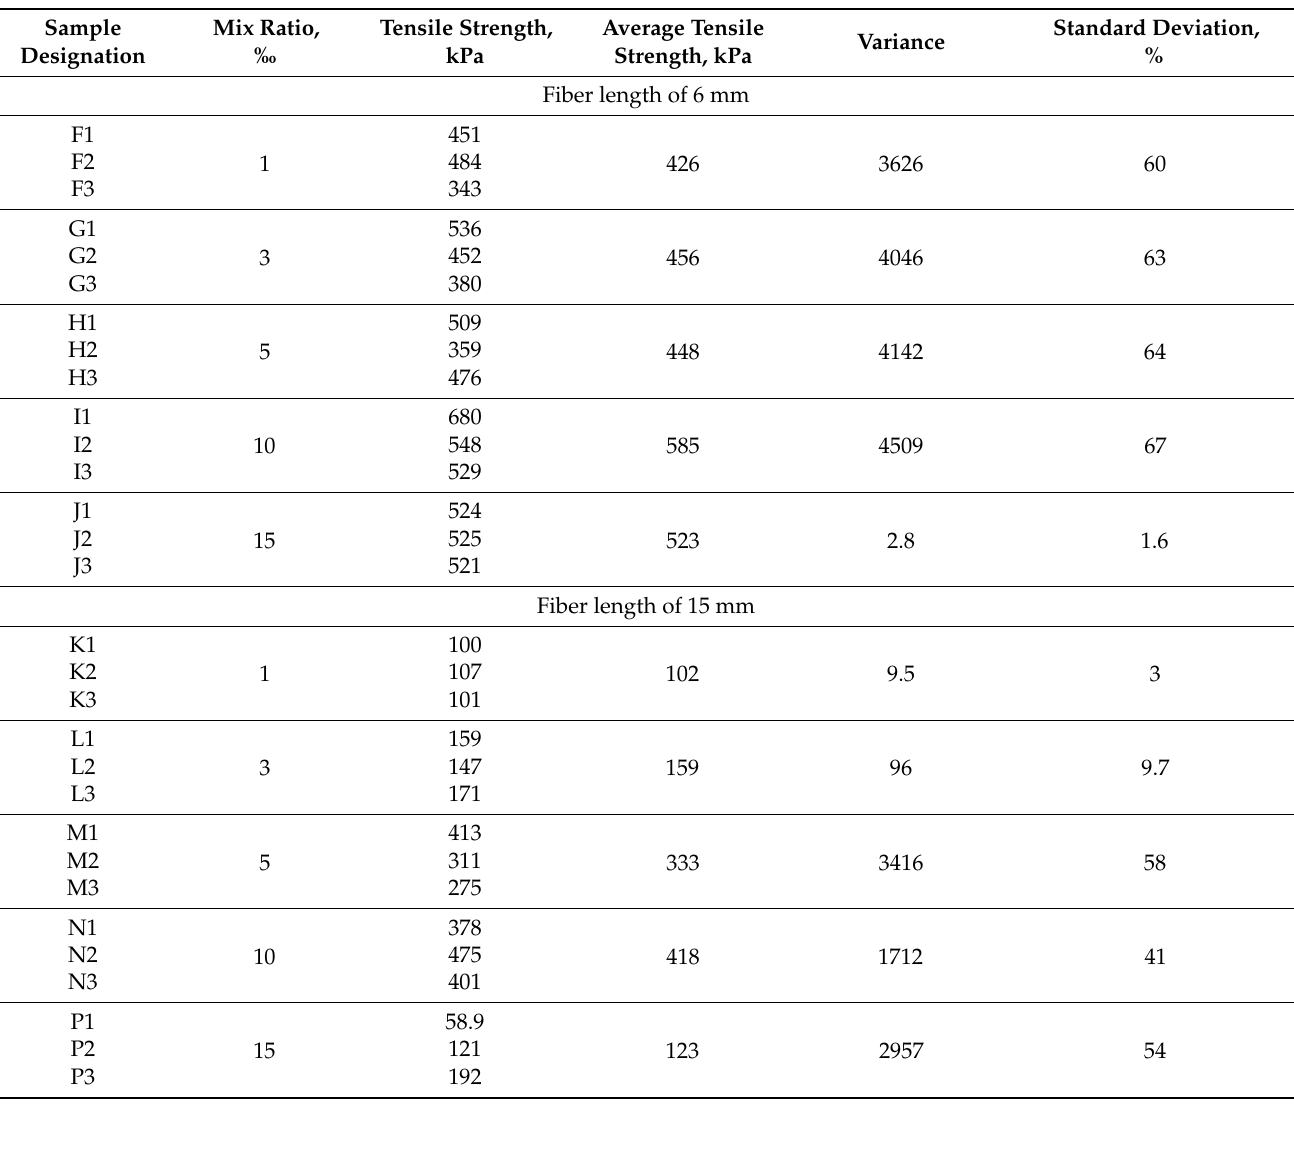
Figure 9. Tensile stress–strain curves for different mix ratios ( a – o ).